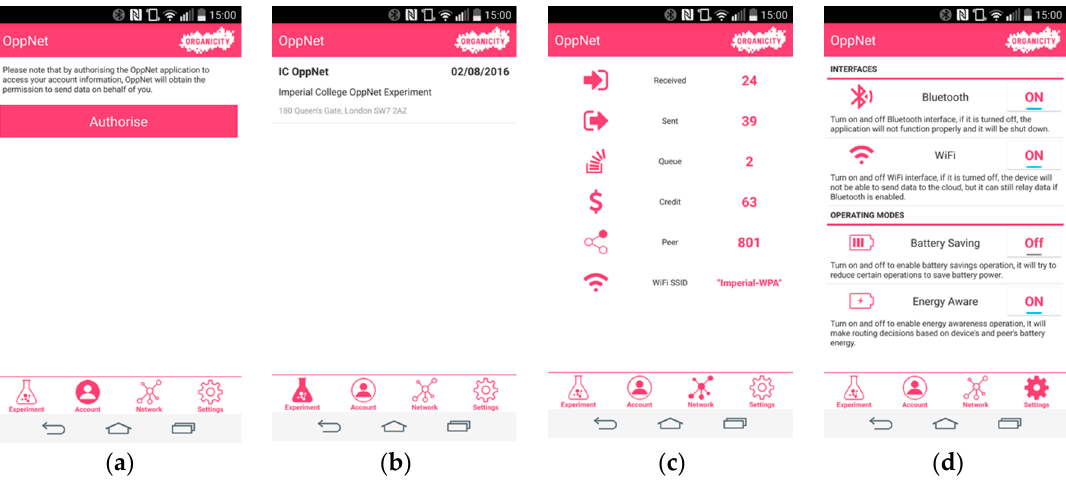
Figure 12. Screenshots from the OppNet smartphone application, ( a ) Authentication; ( b ) Experiments List; ( c ) Network; ( d ) Settings.